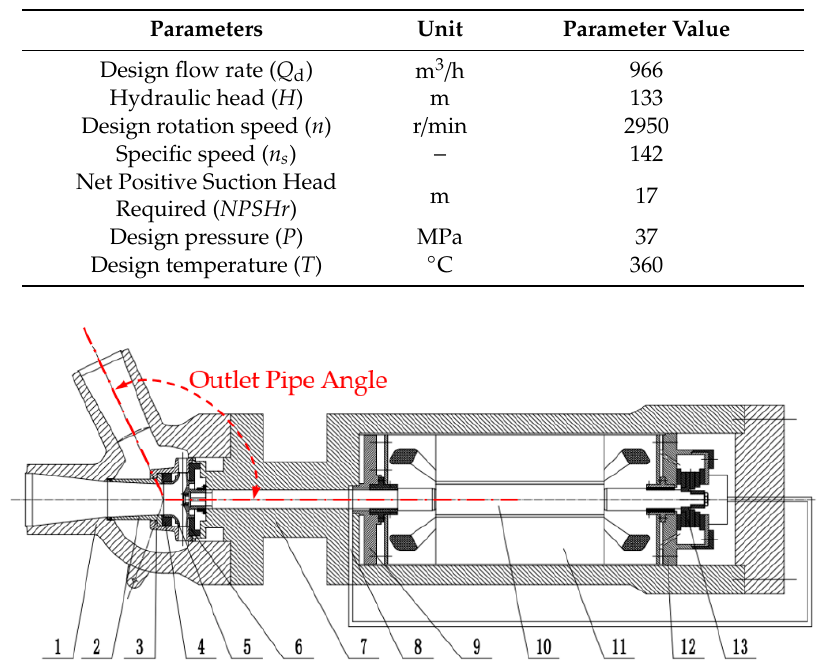
Table 1. Pump design parameters.